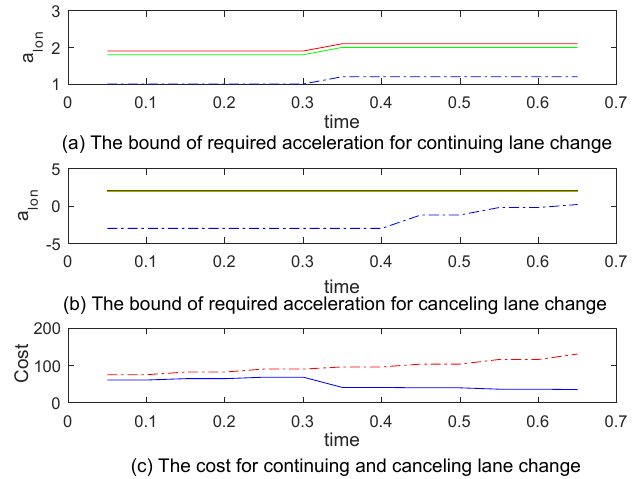
Figure 15. The maneuver evaluation result at 0.65 s with a lon =